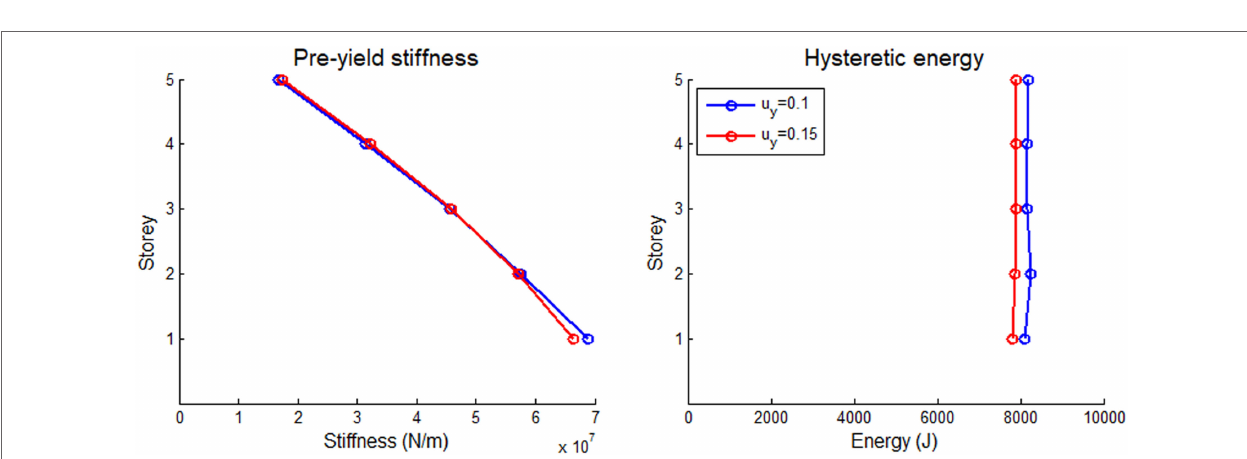
FIGURE 12 | Optimum distributions of elastic pre-yield stiffness and energy dissipated due to hysteresis for the 5-storey shear building with ξ = 5% subject to the El Centro earthquake record for various normalized yield inter-storey drifts.